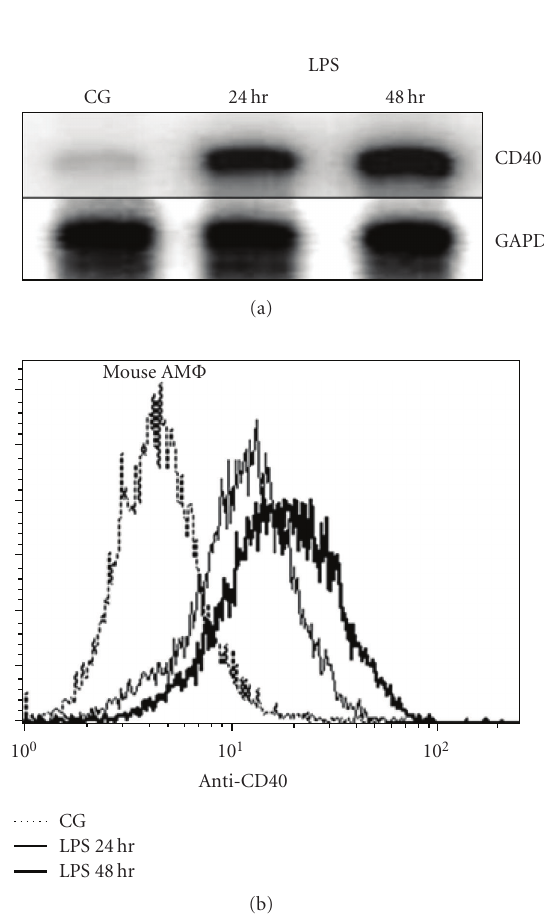
Figure 4: mRNA and protein expression of CD40 in AM Φ by RT- PCR and flow cytometry, respectively, (a) a representative agarose gel electrophoresis showing PCR amplification of CD40 and β -actin from cultured AM Φ with control group and LPS group (at 24, 48 hours), (b) protein expression of CD40 in AM Φ with control group and LPS